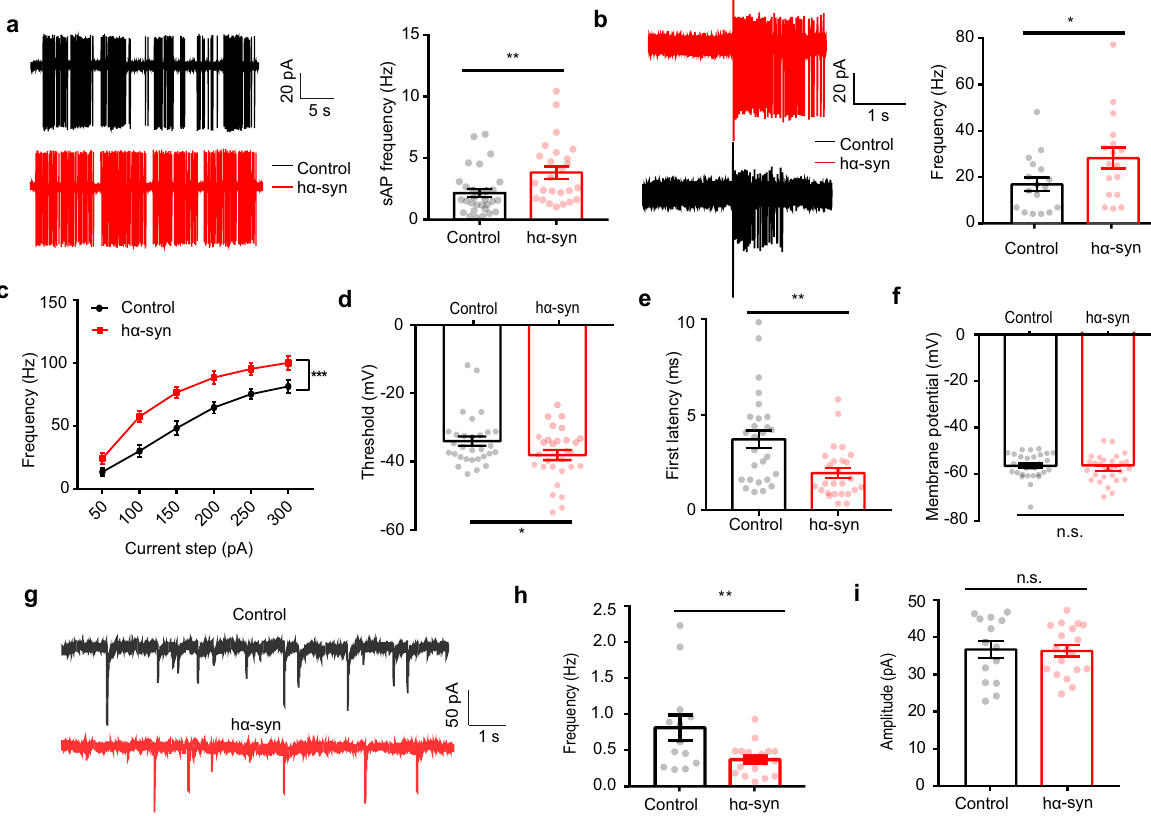
Fig. 5 α -Synuclein aggregates increase spontaneous and evoked fi ring in mitral cells in vitro. a Representative (left) and quantitative analysis (right) of spontaneous fi ring rates of mitral cells (control: 30 cells from 13 mice; h α -syn: 25 cells from 15 mice) over a period of 5 min. b Representative (left) and quantitative analysis (right) of olfactory-nerve-evoked fi ring rates of mitral cells (17 cells from 11 control mice and 17 cells from 8 h α -syn group mice) in a 1.8 s recording period (olfactory nerve stimulation; 200 ms, 400 mA). c – f Quantitative analysis of the frequency ( c ), threshold voltage to trigger fi rst AP ( d ), onset latency ( e ), and membrane potential ( f ) elicited by positive current injections (control: 30 cells from 11 mice; h α -syn: 29 cells from 7 mice). g Representative mIPSCs recorded from M/Ts in control and h α -syn slices. h , i Quantitative analyses of mIPSCs frequency ( h ) and amplitude ( i ) over a 5-min recording period ( n = 14 neurons from 5 mice and 19 neurons from 4 mice; control and h α -syn groups, respectively). sAP spontaneous action potential, mIPSC miniature inhibitory postsynaptic current; * p < 0.05; ** p < 0.01; *** p < 0.001; n.s. not signi fi cant. Data are presented as mean ±